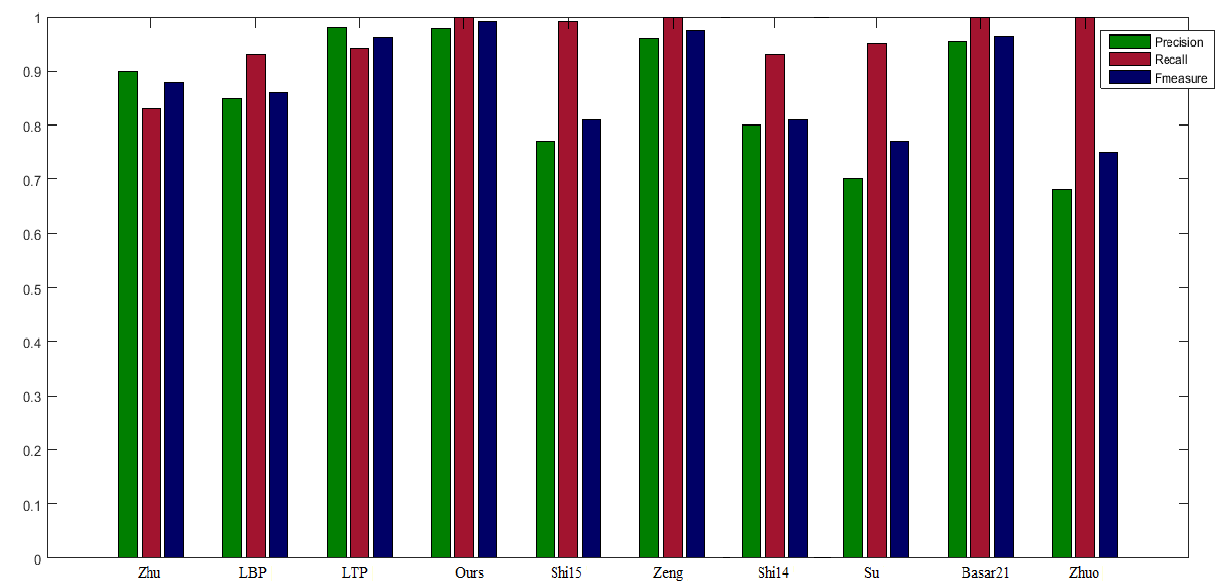
Figure 9. Results comparison of Precision, Recall, and F1-score for using adaptive thresholds. Zhu [19] applied the graph cut method instead of simplified thresholding. LTP [22] algorithm is obtained by applying a lower threshold value, i.e., Td seg = 0.35. Our proposed scheme can obtain comparative result (precision = 0.9894, recall = 1, F1-measure = 0.9990). The other comparative methods used are